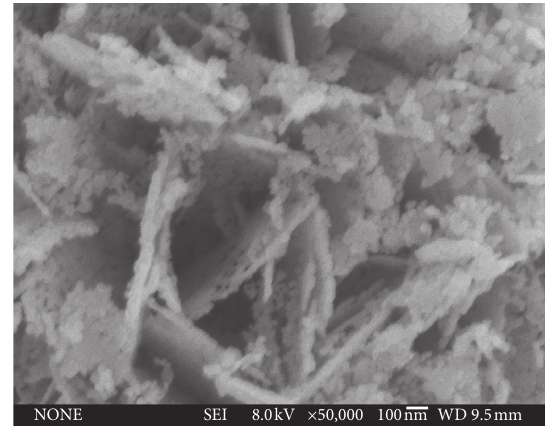
Figure 1: SEM image of nano-TiO